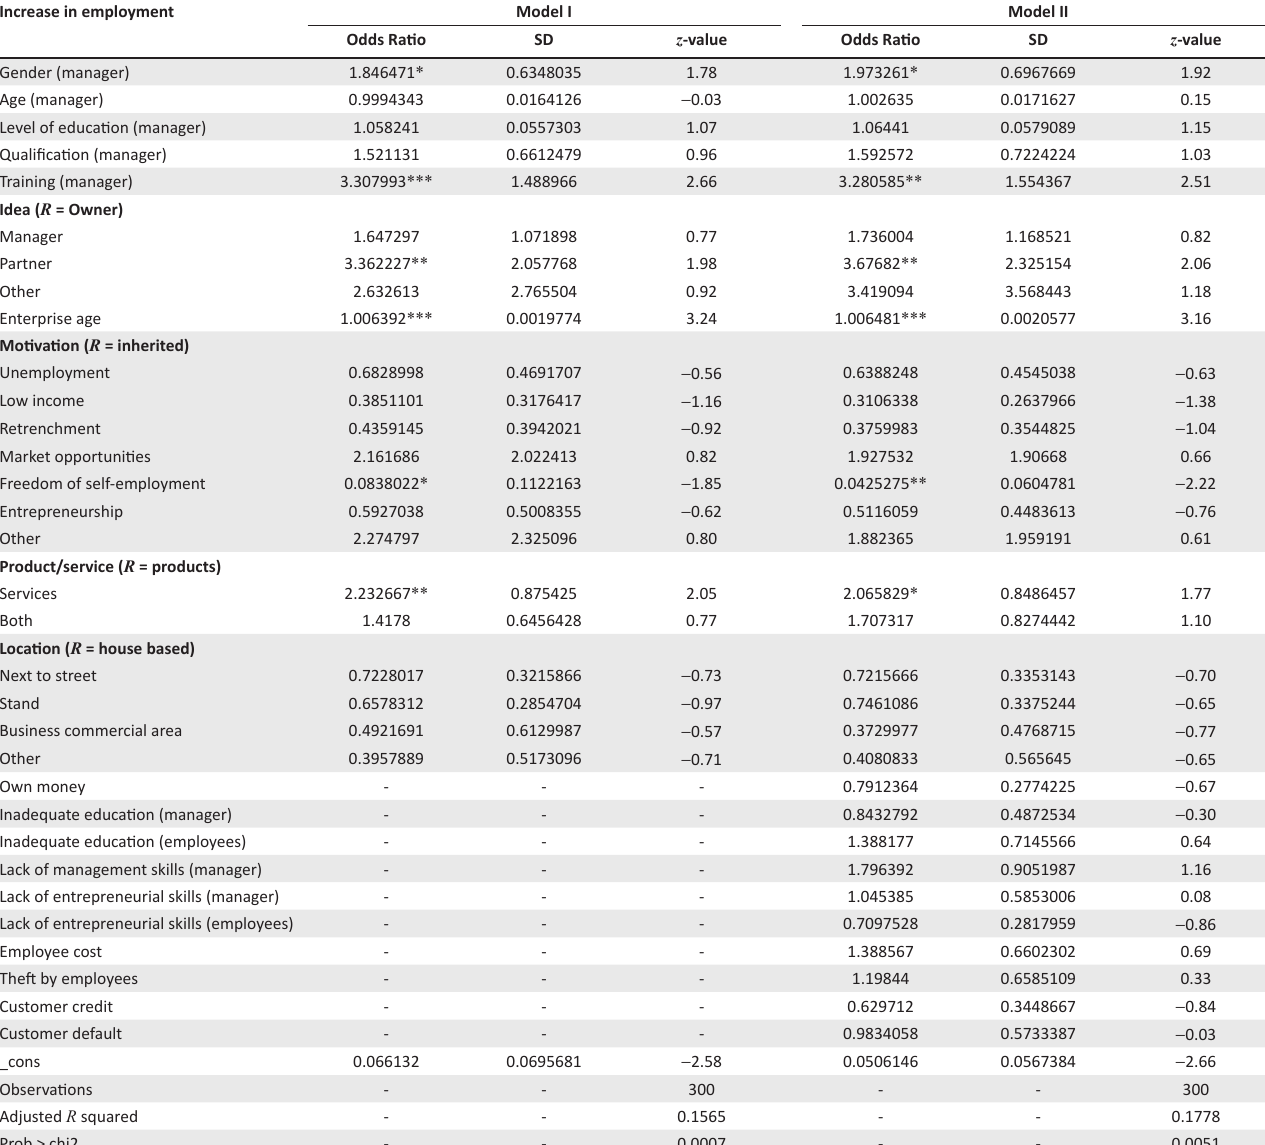
TABLE 6: Relationship between enterprise growth and manager and enterprise characteristics and internal constraints: Logit regression